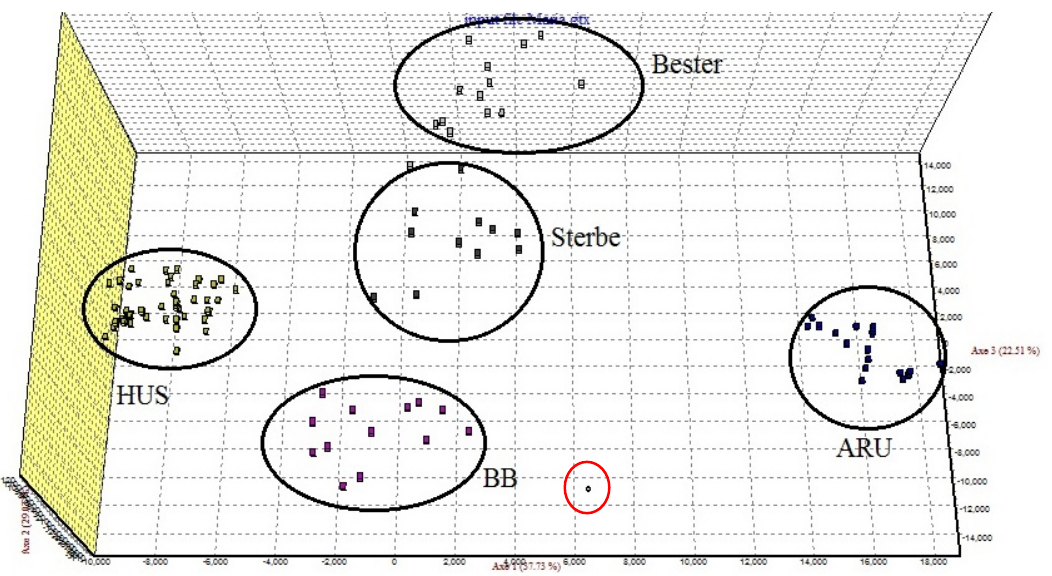
Figure 2. Factorial correspondence analysis (FCA) based on microsatellite data in five sturgeon species. HUS— H. huso ; AST— A. stellatus ; ARU— A. ruthenus ; AGU— A. gueldenstaedtii ; ABE— A. baerii .